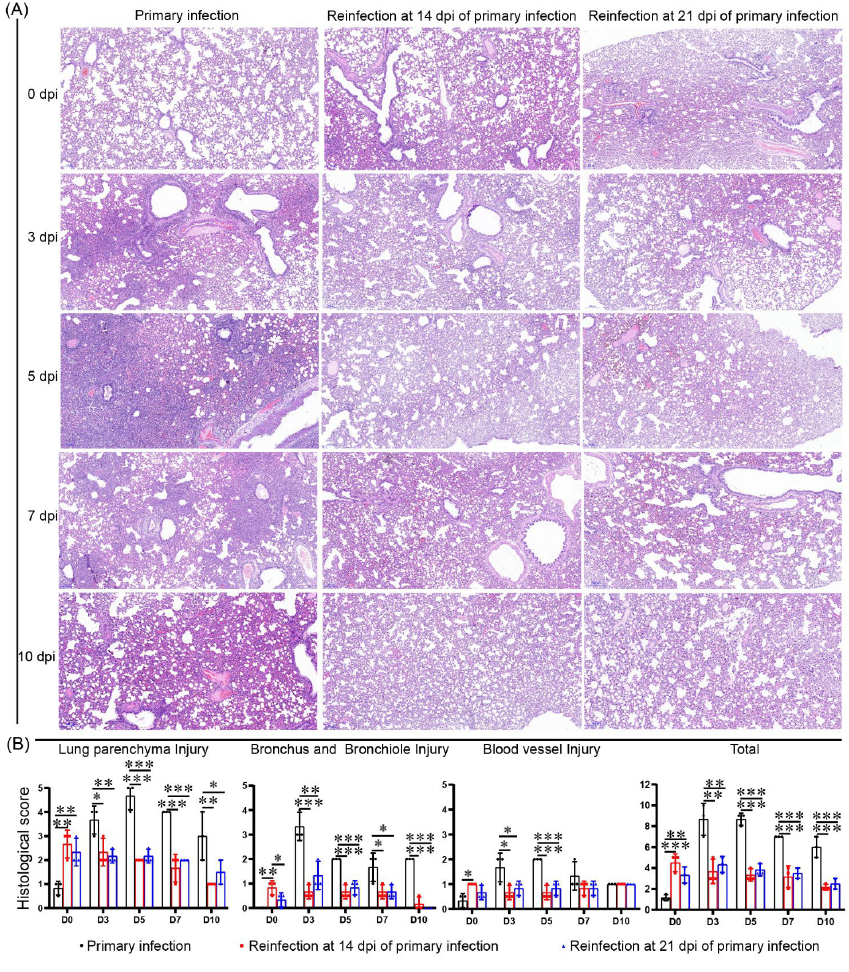
Figure 7. No enhanced pathological changes in the lung were observed during the reinfection of hamsters recovering from severe lung damage from the primary infection. ( A ) Pathological damage to the lung after SARS-CoV-2 primary infection and reinfection was detected by HE staining. ( B ) The scoring of histopathological changes to quantify lung injury, including pulmonary parenchyma, bronchus and bronchiole, and pulmonary vasculature. The histology score standards are shown in Table S2. n = 3 at every point, the data were analyzed using GraphPad Prism 8, and the p -values were calculated by one-way ANOVA using SPSS PASW statistical software version 18.0. * 0.01 < p ≤ 0.05, ** 0.001 < p ≤ 0.01, and *** p ≤ 0.001.